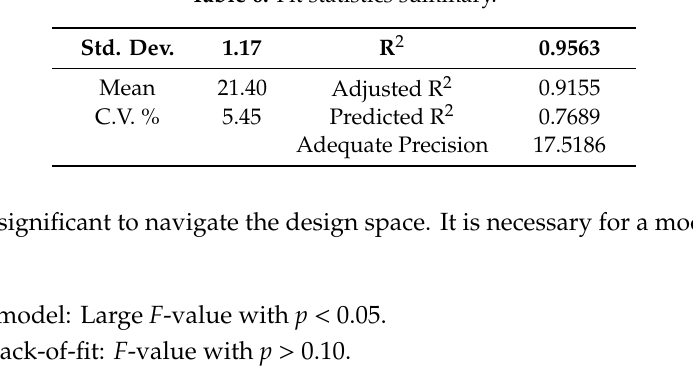
Table 6. Fit statistics